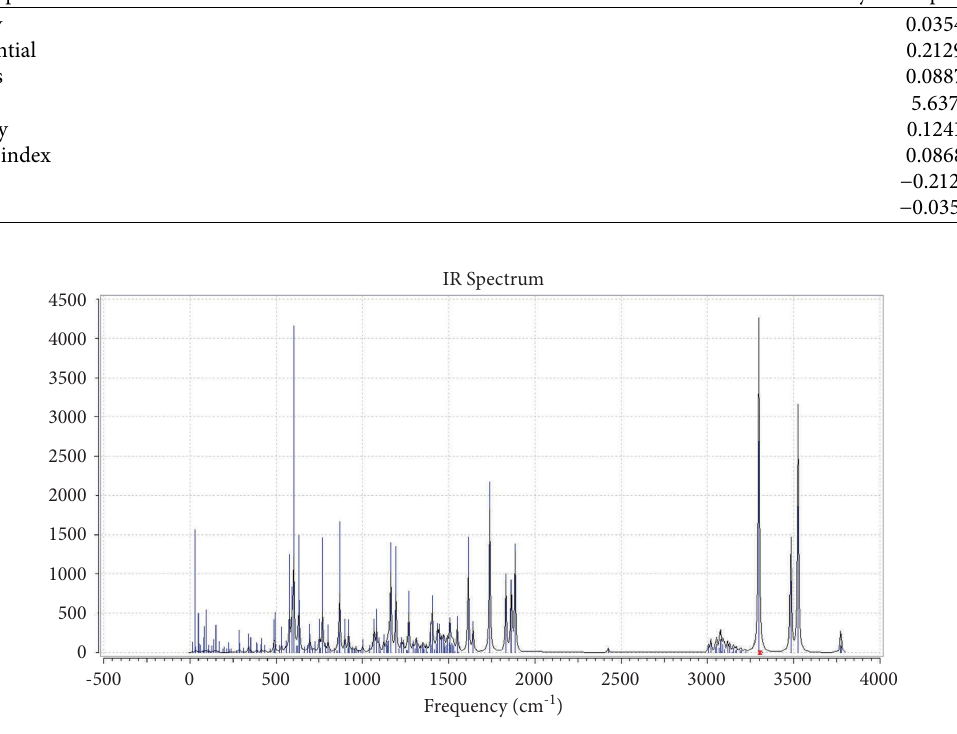
Figure 6: Te calculated IR spectrum for TFC compounds.